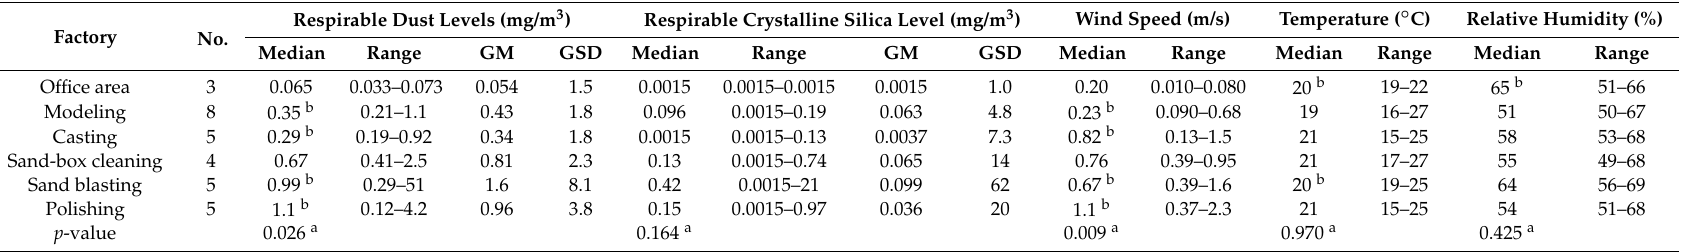
Table 2. Descriptive statistical parameters of respirable dust, respirable crystalline silica (RCS), and climatic factors for different processes. Factory